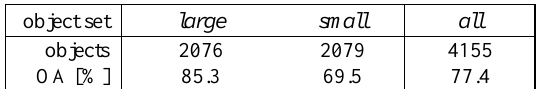
Table 3: OA for three different sets of objects based on EN(B0, B1); objects: number of objects in the set.